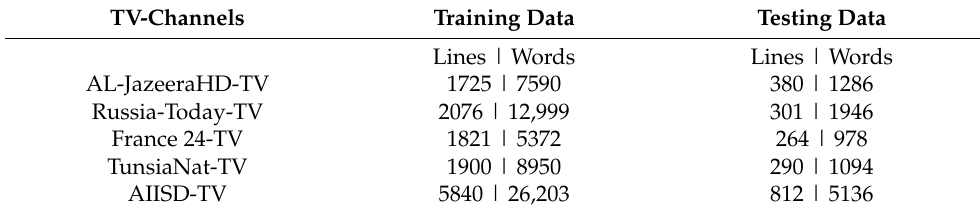
Table 1. Statistical detail of ACTIV dataset.